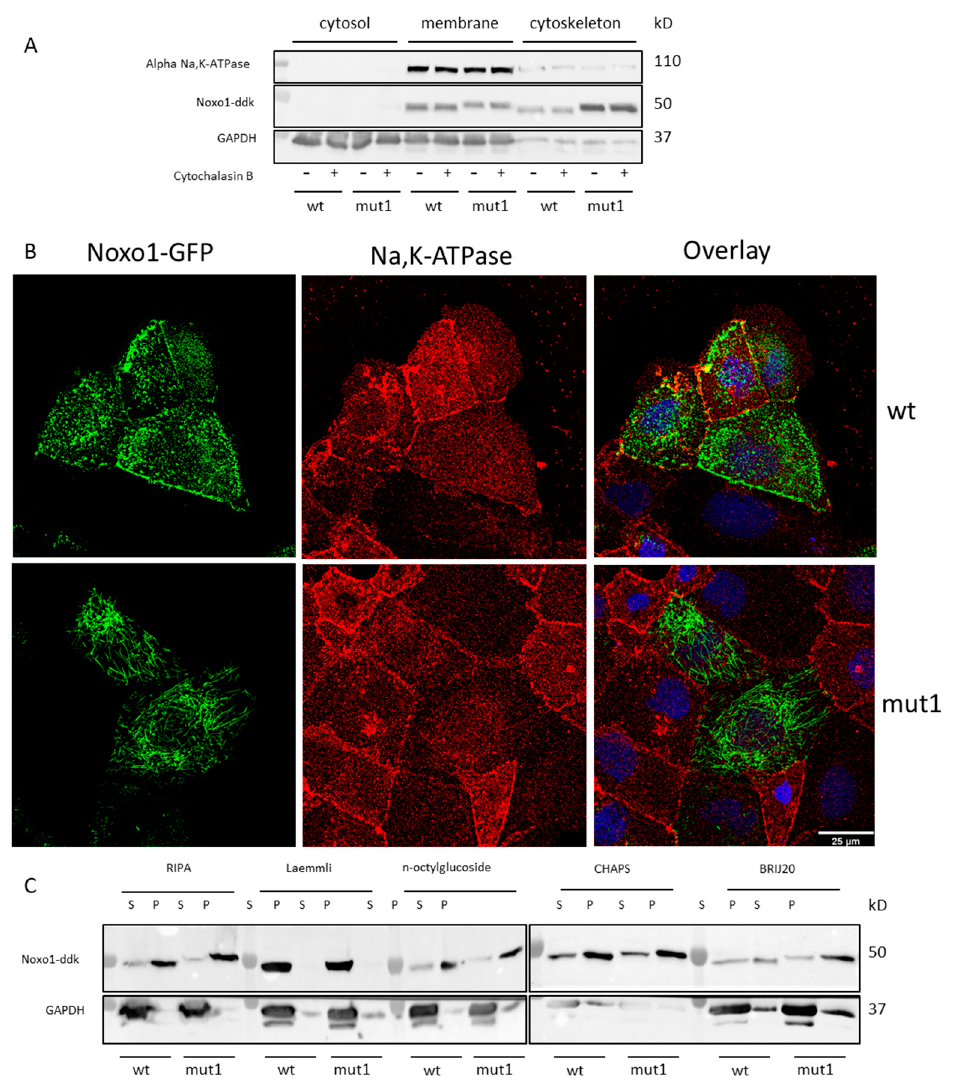
Figure 6. Wt and mut1 Noxo1 localization after subcellular fractioning. ( A ) Subcellular fractioning of Caco-2 cells were transfected by wt or mut1 Noxo1-DDK was performed using ProteoExtraction Subcellular Proteosome Extraction Kit according to manufacturer recommendations. The different fractions were revealed for Noxo1-DDK, alpha Na,K-ATPase (control for membrane), and GAPDH (control for cytosol and membrane) by immunoblot. Mut1 Noxo1 is predominantly present in the cytoskeletal fraction, while wt Noxo1 is predominantly present in the membrane fraction. F-actin depolymerizing agent, cytochalasin B (1 µM, 1 h before lysis) didn’t affect wt and Mut1 Noxo1 subcellular localization. ( B ) Double immunofluorescence of alpha Na,K ATPase protein (red), and Noxo1-GFP (green). Scale bar in all panels: 25 µm. ( C ) Caco-2 cells were transfected by wt or mut1 Noxo1-DDK and lysed in different buffers (RIPA; Laemmli, n-octylglucoside; CHAPS, Brij20) followed by separation of supernatant (S) and pellet (P) after centrifugation (15,000 g , 5 min). Noxo1-DDK and GAPDH were revealed by immunoblot using DDK and GAPDH antibodies.